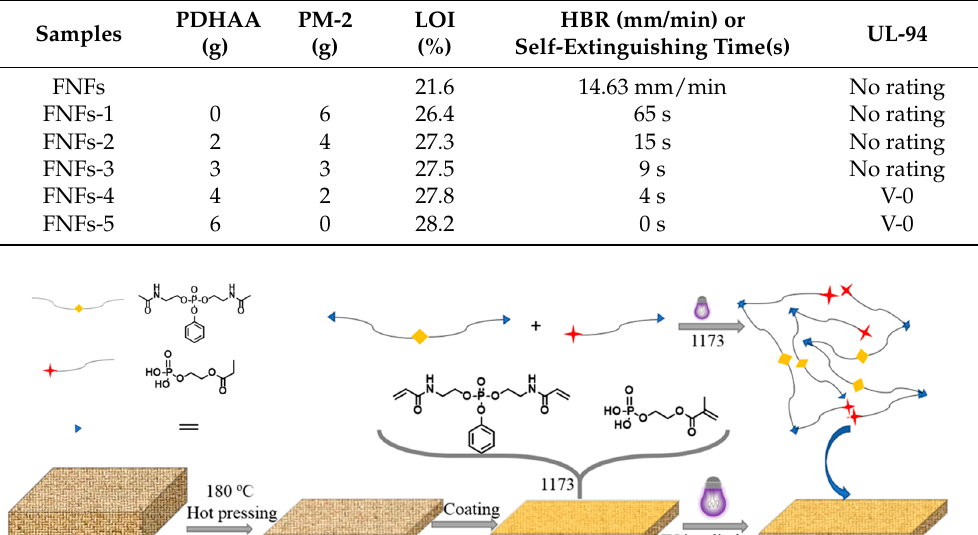
Table 1. Formulation and fl ame retardancy of the UV-cured coatings.